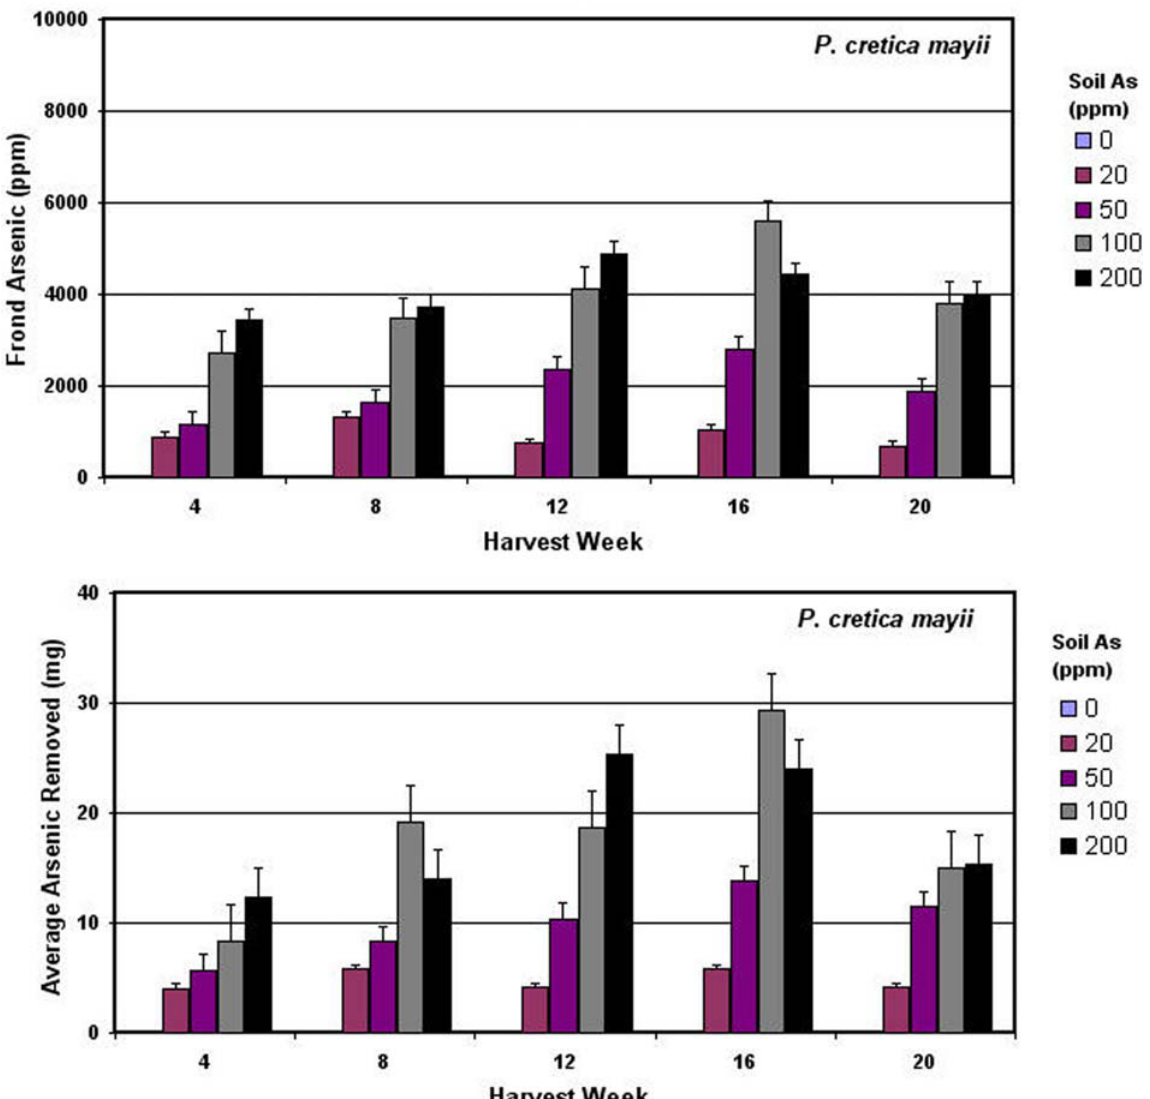
Figure 7. Arsenic Uptake Summary for Pteris cretica mayii . Arsenic concentration and content in the arsenic-hyperaccumulating fern Pteris cretica mayii . Peak concentration and content were observed after 16 weeks and, in several cases, Pteris cretica mayii seemed to accumulate more arsenic from the 100 ppm concentration than the 200 ppm